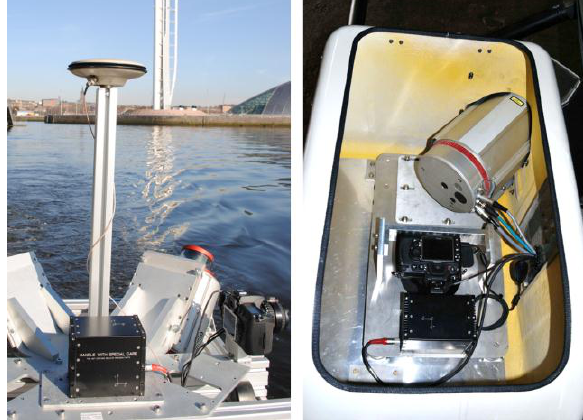
Figure 2: Scanner, camera and IMU of a StreetMapper mounted on a boat and in a helicopter pod